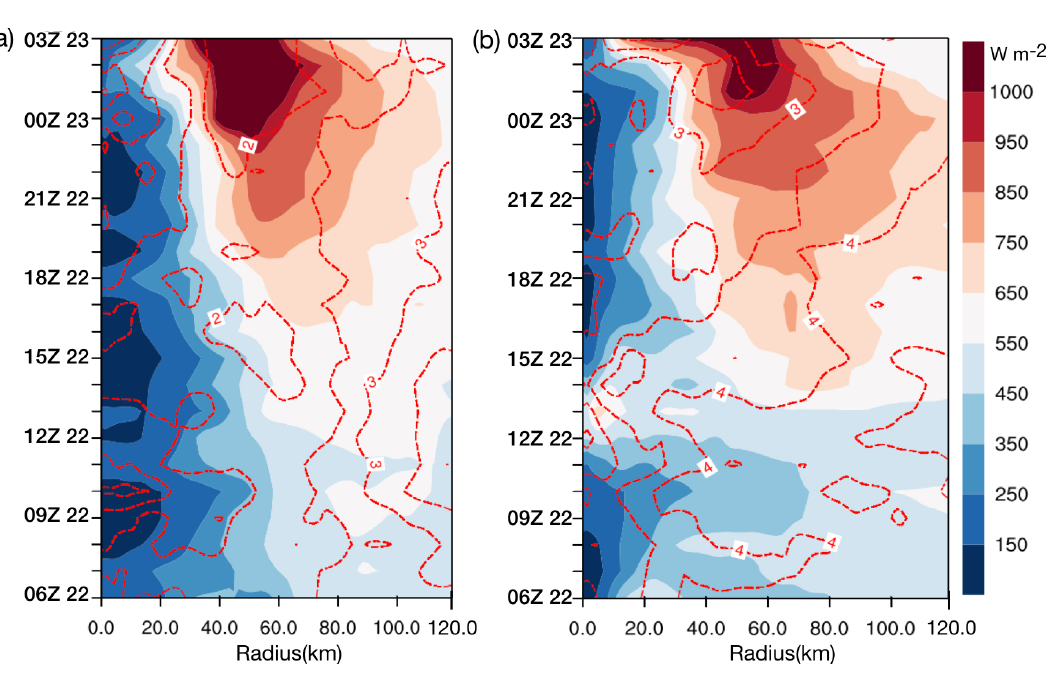
Figure 12. Evolution of the azimuthally averaged surface latent heat flux (shade, W m − 2 ) and ∆ q on the lowest model later (red contours with the interval of 0.5 g kg − 1 ) for the ( a ) CPL and ( b ) FO experiment, respectively. Ordinate values are time from 0600 UTC on 22 August to 0300 UTC 23